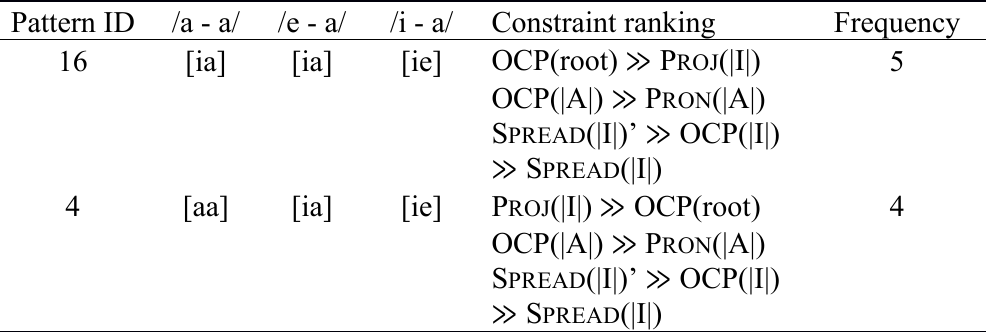
Table 6 . Factorial typology for attested opaque